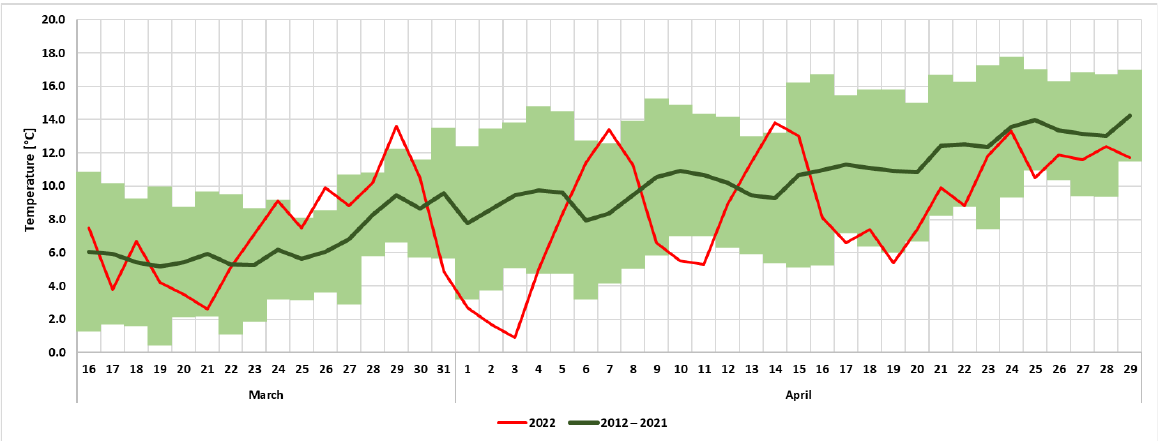
Figure 1. Daily average temperature in the experimental year and the average of the previous 10 years (the area shaded in light green shows the standard deviation of the average over ten years).